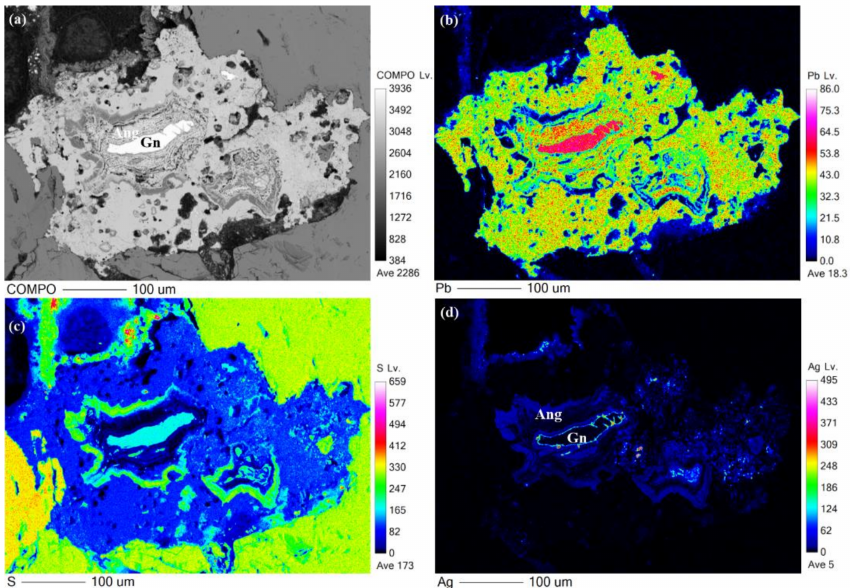
Figure 5. ( a ) BSE image of Ag–Bi-enriched anglesite and galena. X-ray elemental distribution maps after EPMA of BSE image, showing compositional heterogeneity of anglesite crystals in ( b ) Pb; ( c ) S; ( d ) galena with Ag-enriched anglesite rim and veins.